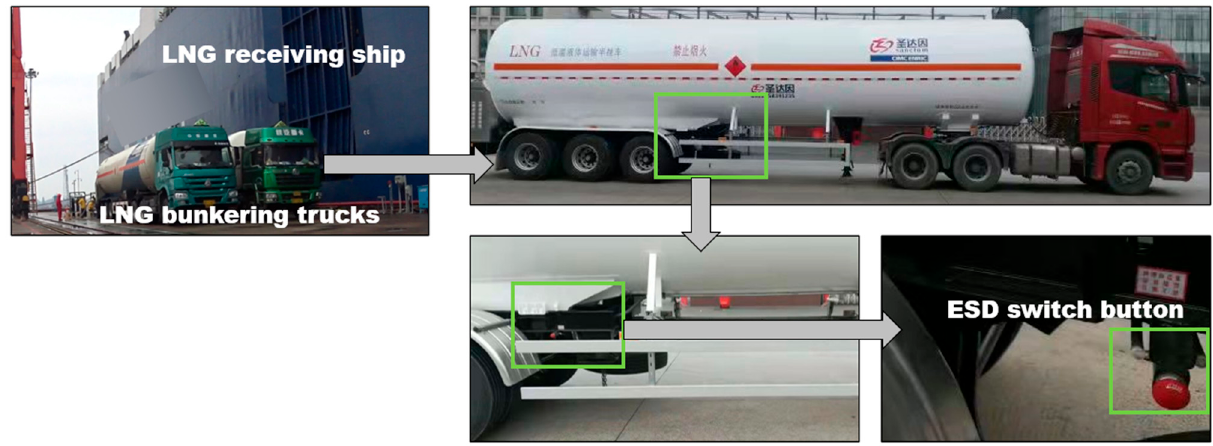
Figure 1. A truck-to-ship LNG bunkering scenario.